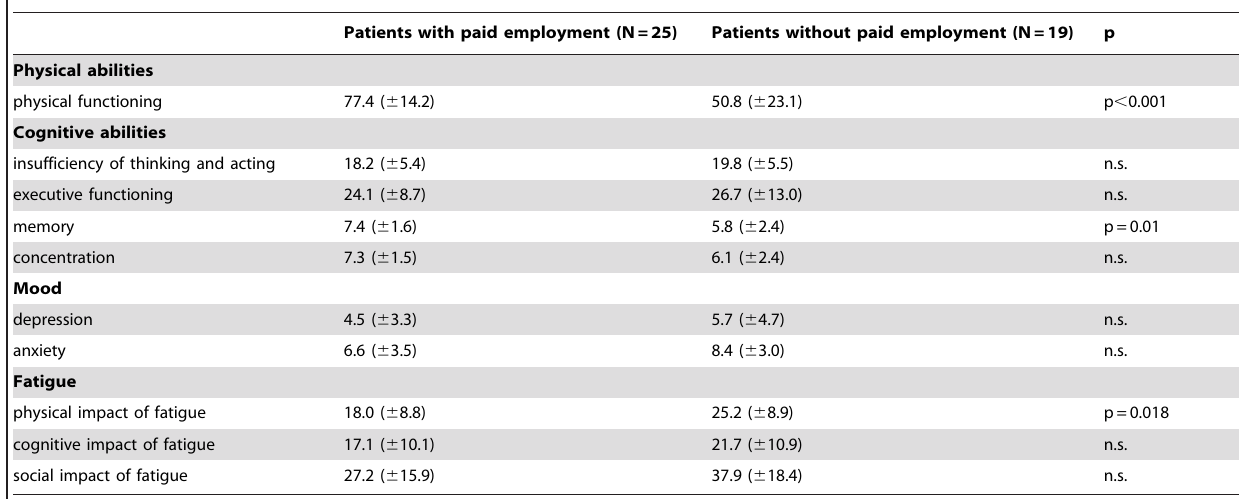
Table 2. Differences in self-reported functioning between patients with and without paid employment.